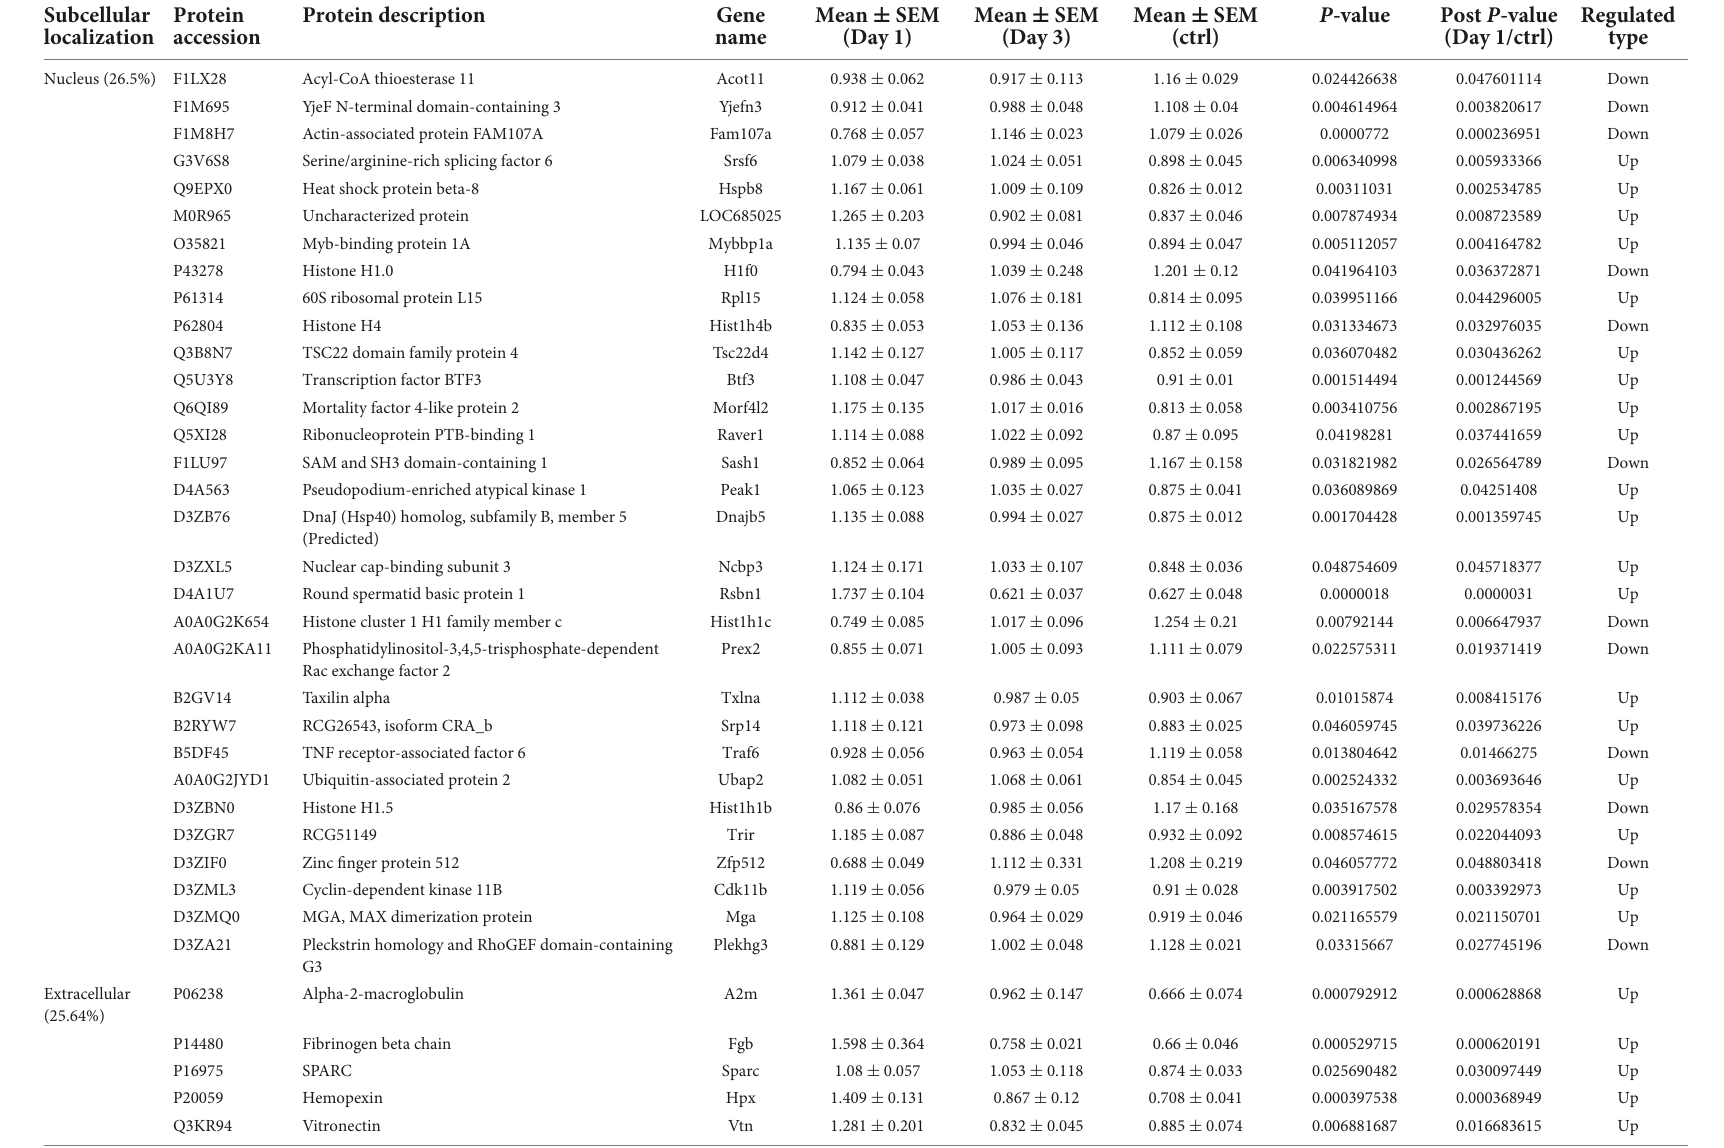
TABLE 4 Cellular distribution of differentially expression proteins on Day 1 comparing with control (ctrl) by ANOVA analysis in hippocampus. Subcellular Protein localization